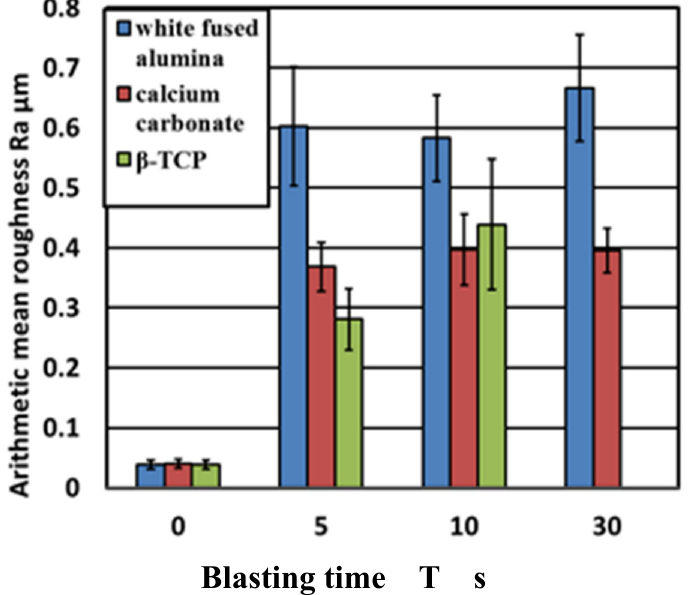
Figure 6. The changes in surface roughness are shown. It was confirmed that the surface roughness increased significantly under all conditions. From this, the target roughness Ra = 0.2 µm was greatly exceeded, and there is concern about plaque adhesion.